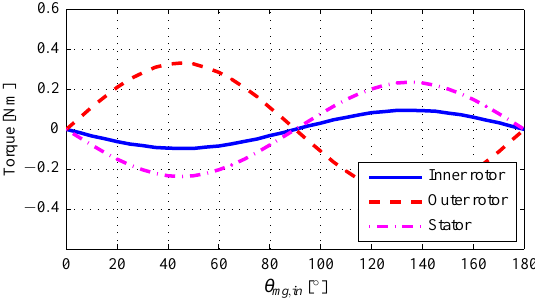
Figure 14. Torque exerted on the the magnetic gear rotors and stator as a function of inner rotor position θ mg , in , while the outer rotor position is fixed.